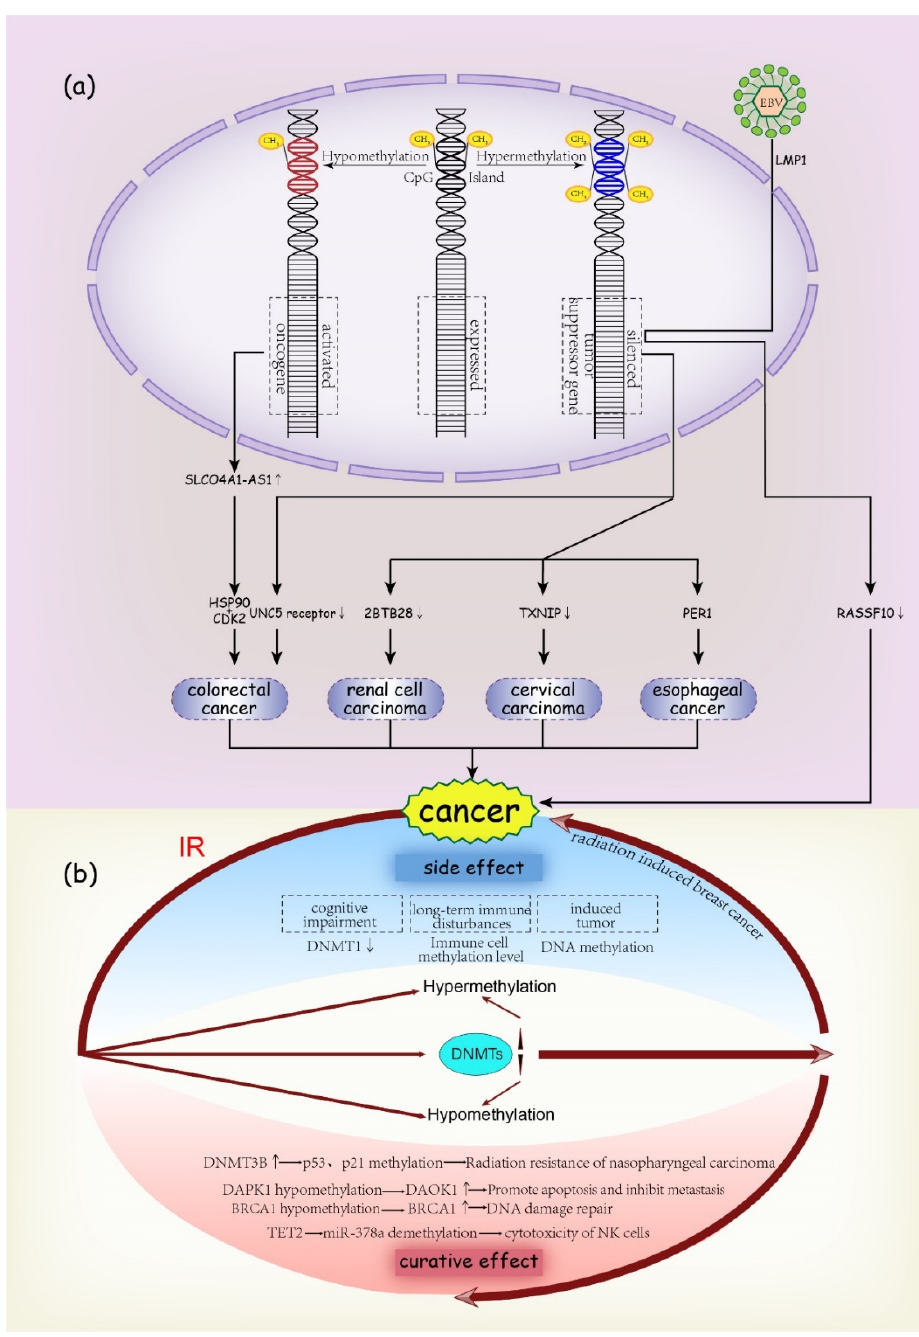
Figure 2. ( a ) DNA methylation changes may be involved in the carcinogenesis and development of cancer, such as hypomethylation leading to the transcriptional activation of oncogenes and hypermethylation leading to transcriptional silencing of tumor suppressor genes. At the same time, viruses may also induce cancer through this mechanism. ( b ) When radiotherapy is used in the treatment of tumors, radiotherapy may also cause different changes in DNA methylation status and DNMT content. These changes may have side effects on the body or have a therapeutic effect. DNMT: DNA methyltransferase. EBV: Epstein-Barr virus.